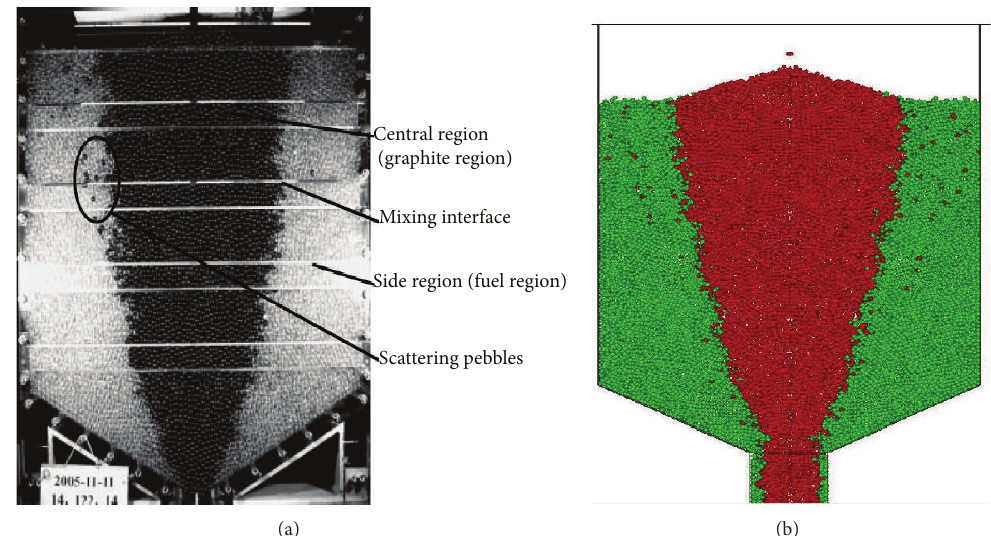
Figure 2: Equilibrium state of the two-region arrangement after about 7.5 h (a) and the counterpart obtained by DEM simulation (b).